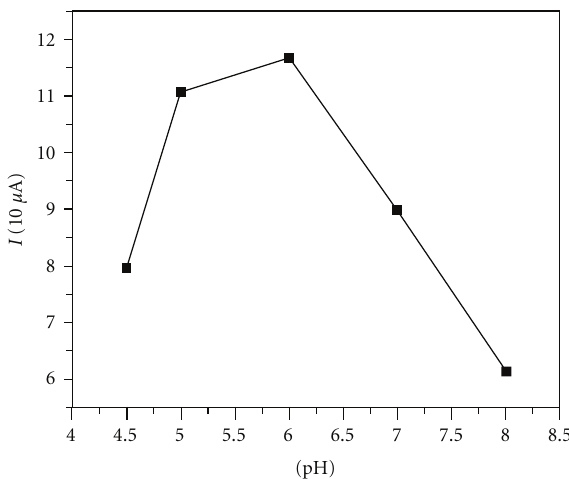
Figure 6: E ff ects of pH on the peak current of 3.43 × 10 − 5 molL − 1 parathion at a safranine modified electrode. Scan rate: 100 mVs − 1 .